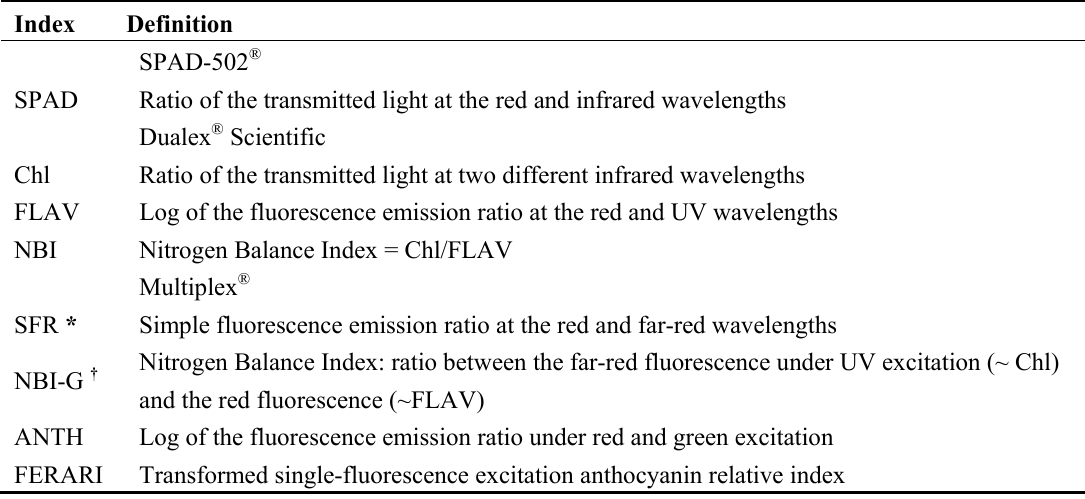
Table 1. Indices calculated from the ground-level sensors used in this study. Chl, chlorophyll; FLAV, flavonoid; NBI-G, Nitrogen Balance Index under green excitation; ANTH, Anthocyanin Content